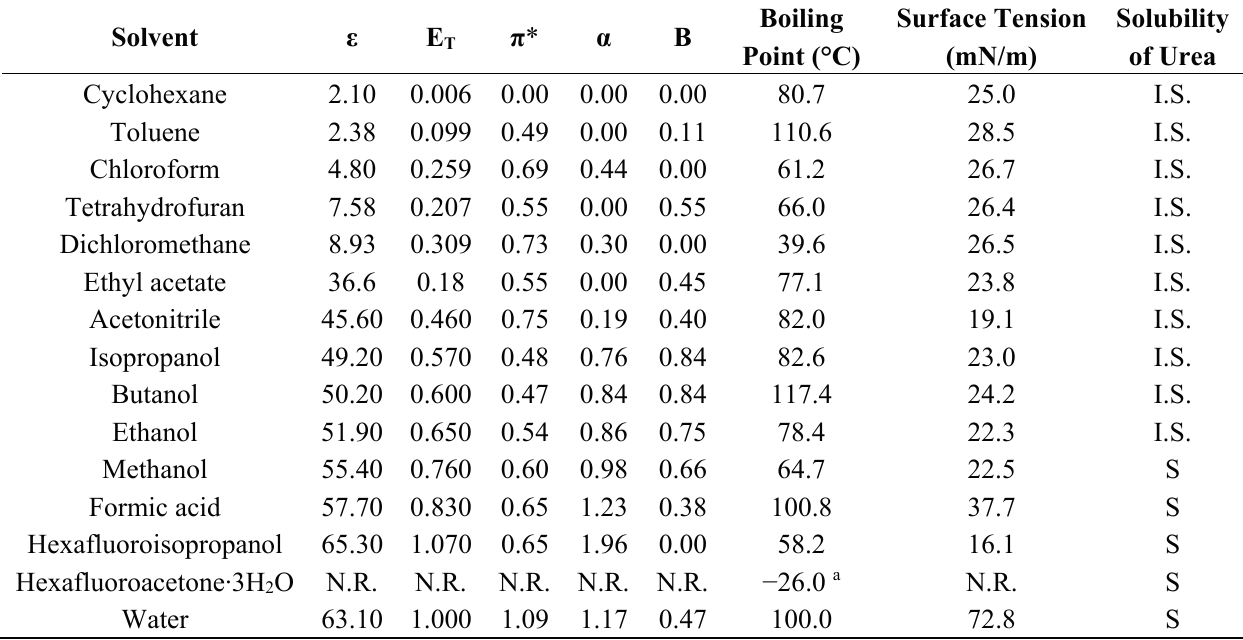
Table 1. The properties of the non-aqueous solvents investigated for the dissolution of urea at a concentration of 100 mg/mL. Solvent parameters: dielectric constant ( ε ), Reichardt’s parameter (E T ), and Kamlet-Taft parameters, π *, α , and β . (N.R.) Not reported in the literature; a Hexafluoroacetone is a gas and it evaporates readily from aqueous solutions; (I.S.) insufficiently soluble; and (S) sufficiently